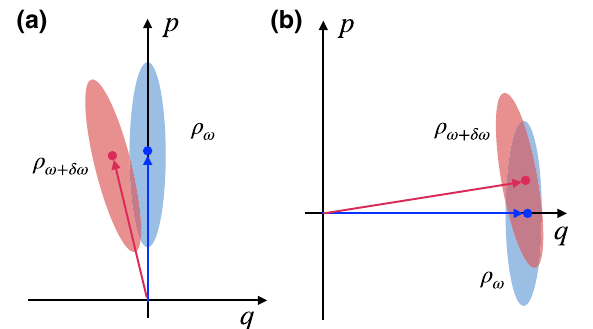
FIG. 1. A heuristic representation in phase space of frequency (phase) estimation via a displaced squeezed state. The estimation precision on the parameter ω can be understood both qualita- tively and quantitatively [72] in terms of the distinguishability of quantum states (cid:4) ω and (cid:4) ω + δω differing by an infinitesimal value δω of the parameter. In (a) we observe that if the state is dis- placed along the ˆ p axis of the phase space and is squeezed along ˆ q , the two states are highly distinguishable, and thus ω can be measured with high precision. However, as one can see in (b), the quantum states become very indistinguishable in the opposite case (i.e., for both displacement and squeezing along ˆ q ).